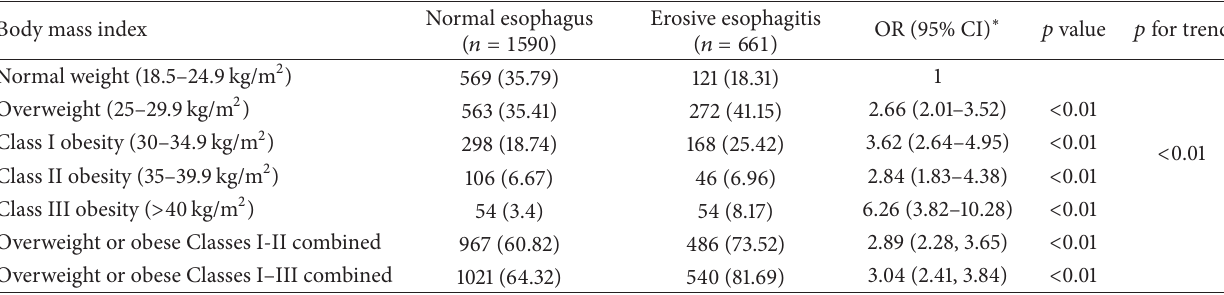
Table 2: Association between obesity and erosive